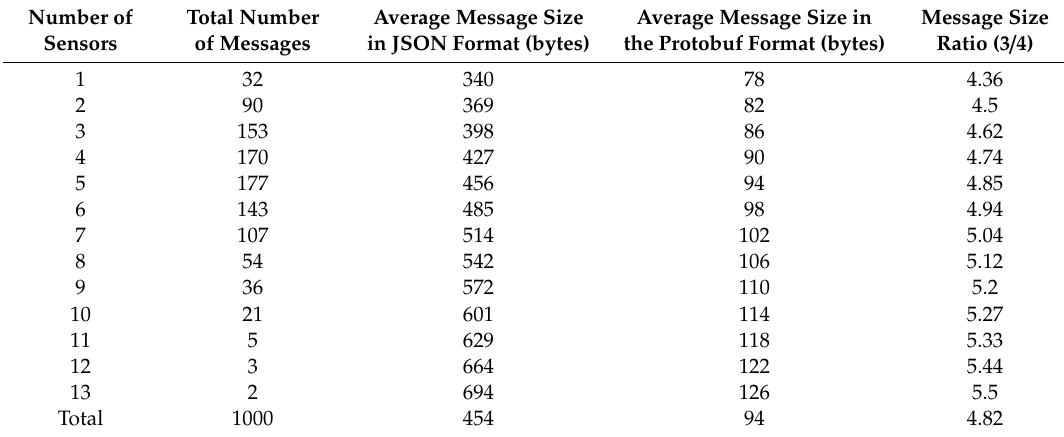
Table 2. Comparison of data transfer encoded in JSON and in the proposed format